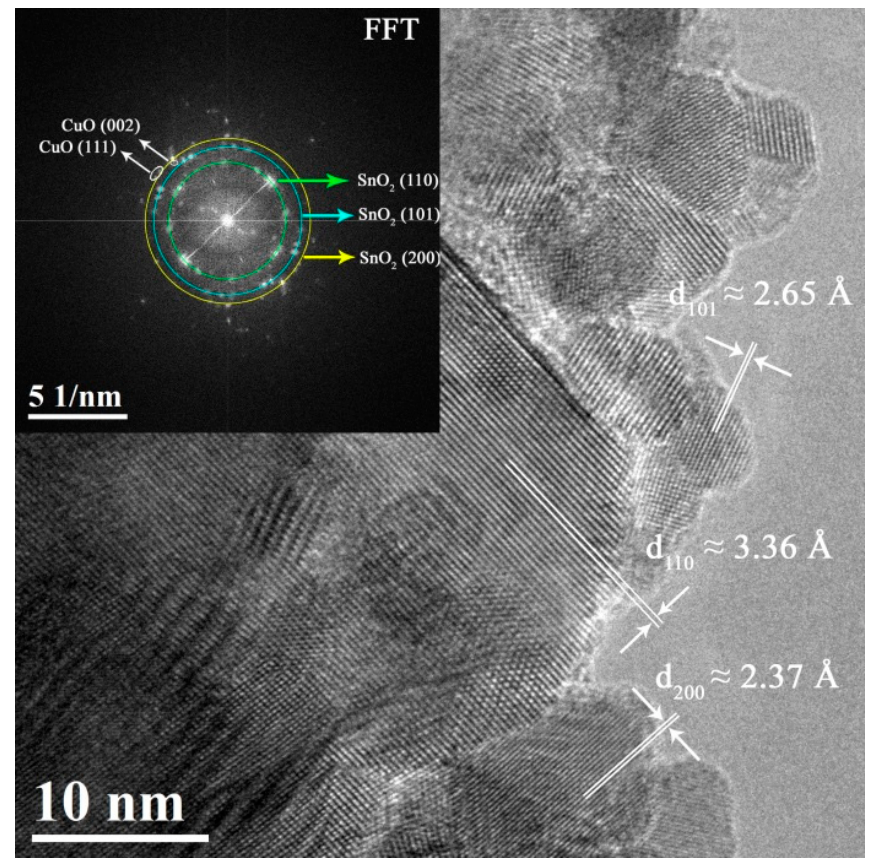
Figure 3. TEM image and corresponding fast Fourier transform (FFT) of the 7 at.% Cu-doped SnO 2 powders.